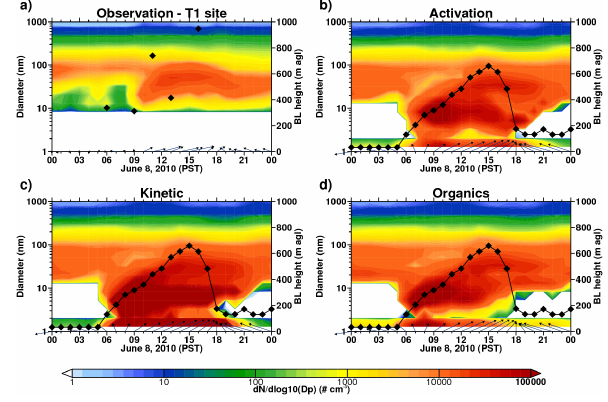
Figure 4. Same as Fig. 3, except for the T1